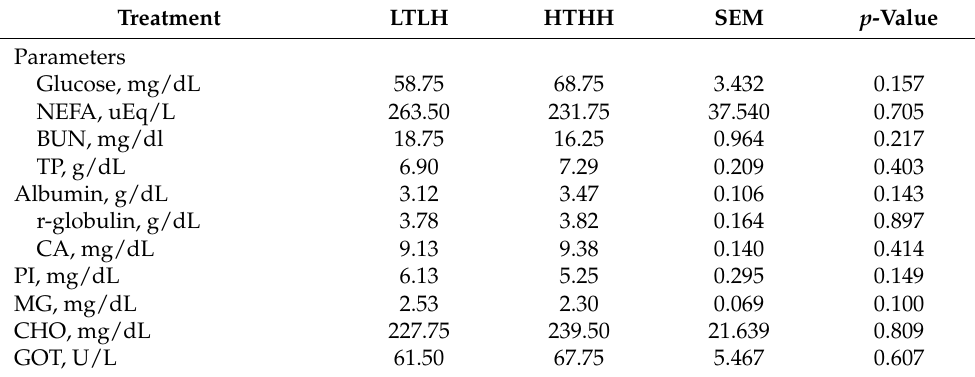
Table 5. Blood chemistry profile in dairy cows exposed to two distinct environmental conditions.